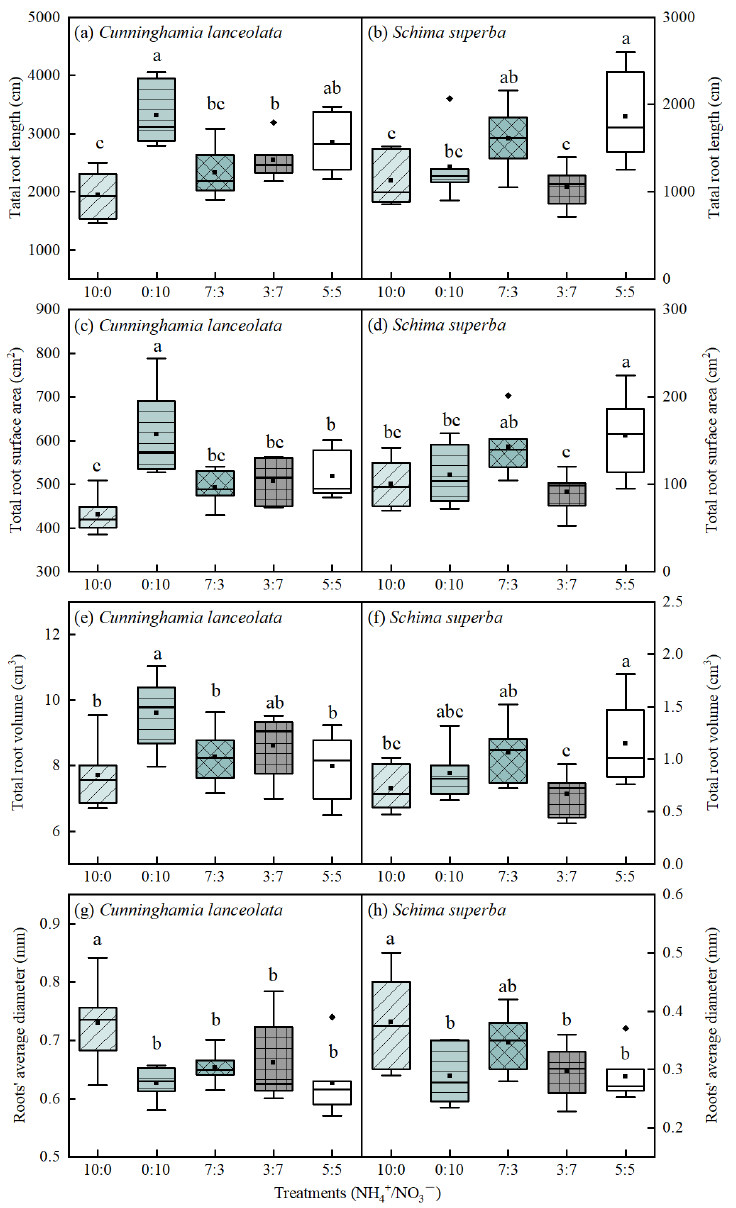
Figure 1. Effects of different NH 4 + -N and NO 3 − -N ratios on the TRL ( a , b ), TRSA ( c , d ), TRV ( e , f ) and RAD ( g , h ) of the two tree species. Different lowercase letters indicate that the roots’ morphological parameters were significantly different under different N forms ( p <